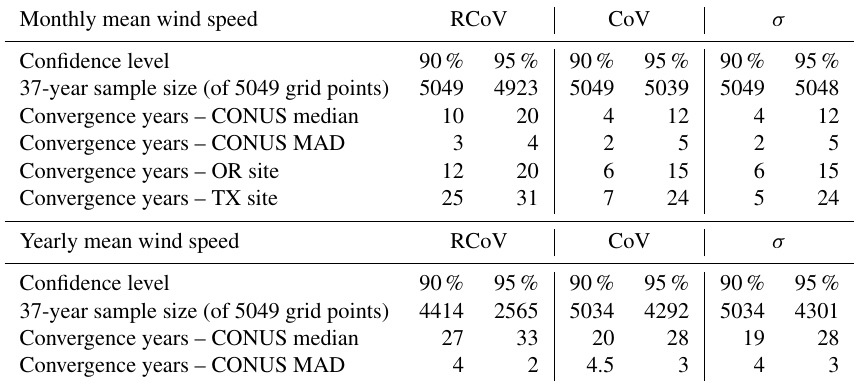
Table B5. Convergence years based on the χ 2 approach of wind-speed RCoV (as in Figs. 8 and 9), wind-speed CoV, and wind-speed σ , using monthly and yearly wind speeds. The calculations of median and MAD exclude the data with convergence years beyond 37 years in the